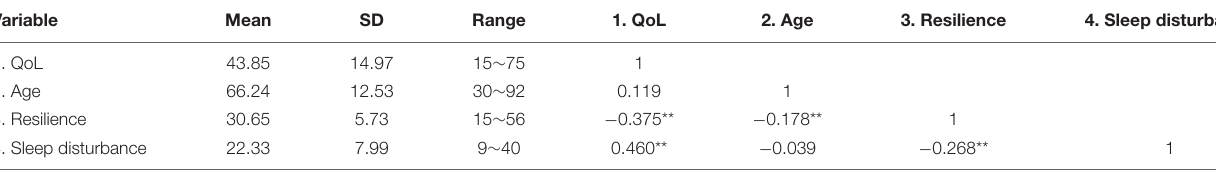
TABLE 2 | The correlations of each continuous variable ( N =